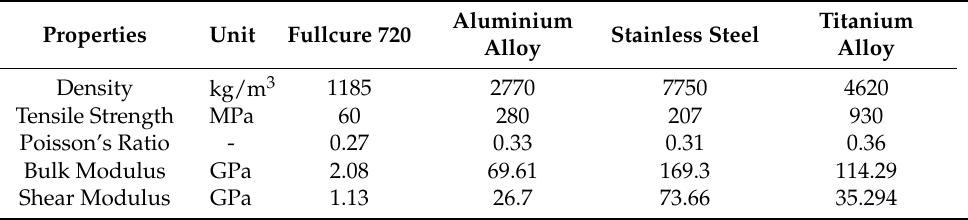
Table 4. Properties of considered